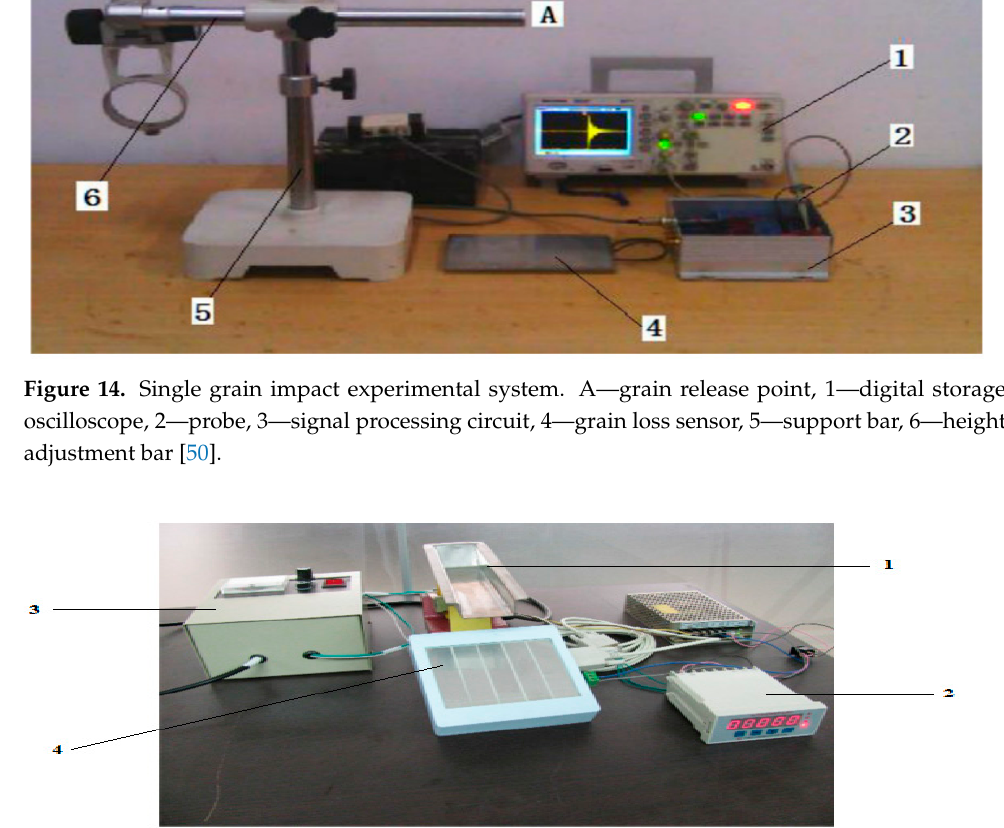
Figure 14. Single grain impact experimental system. A—grain release point, 1—digital storage oscilloscope, 2—probe, 3—signal processing circuit, 4—grain loss sensor, 5—support bar, 6—height adjustment bar [50].